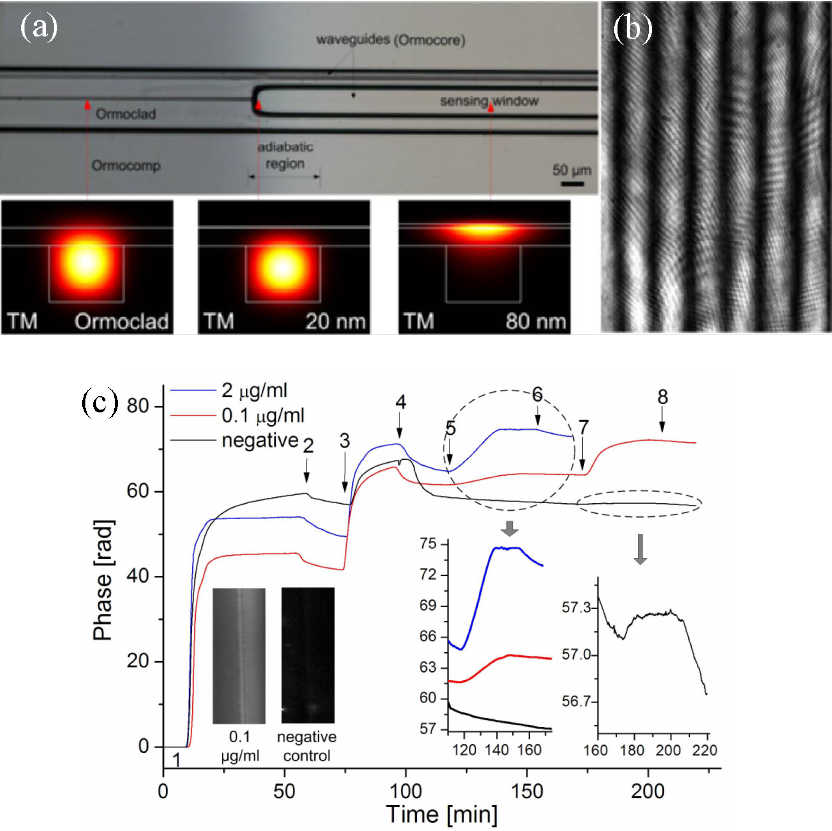
Figure 31. ( a ) Microscope image of the fabricated YI biosensor with a high-index Ta 2 O 5 coating; ( b ) the generated interference pattern on the detector screen at a distance of 2.5 mm; and ( c ) the measured phase responses of the molecular binding events between surface attached CRP antibodies and different concentrations of CRP antigens [88]. Copyright 2012 OSA.